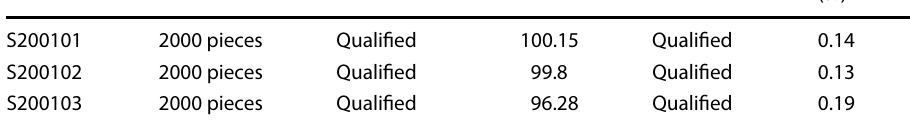
Table 7 Yield of three batches of samples and results of main inspection items (Specification: 22.4 mg/tablet)